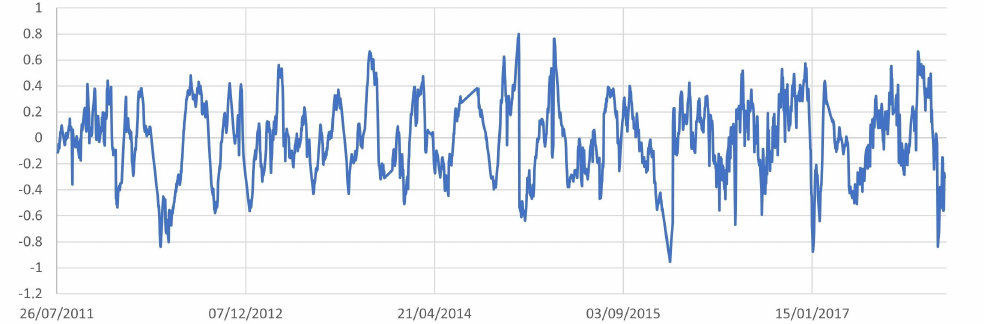
Figure 4. Plot of the time series B H ( t ) = X ( t ) − r ( t )